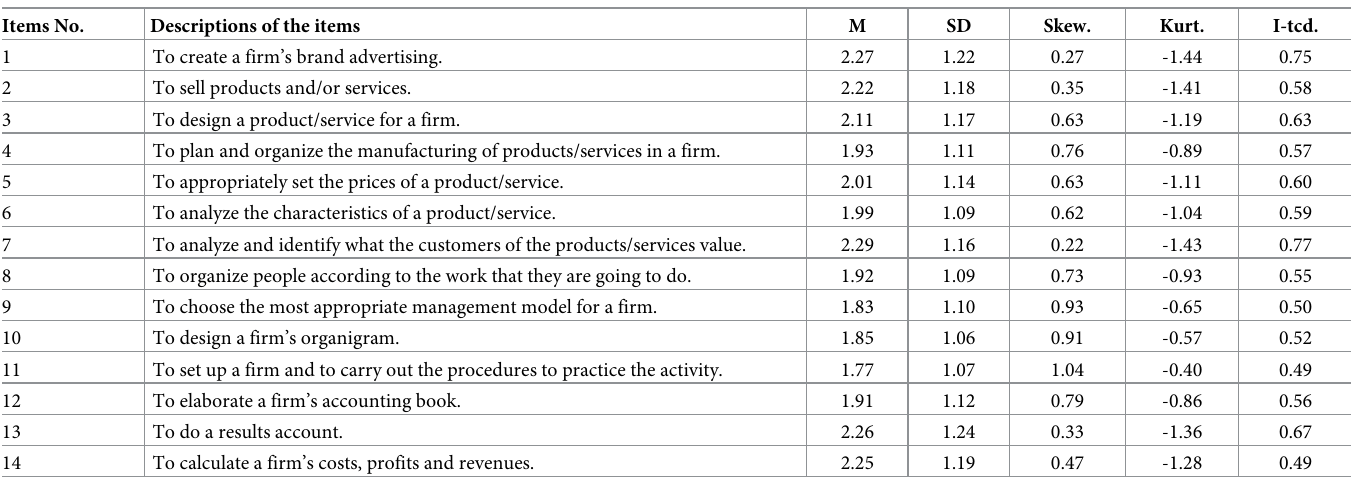
Table 3. Item descriptive statistics and discrimination